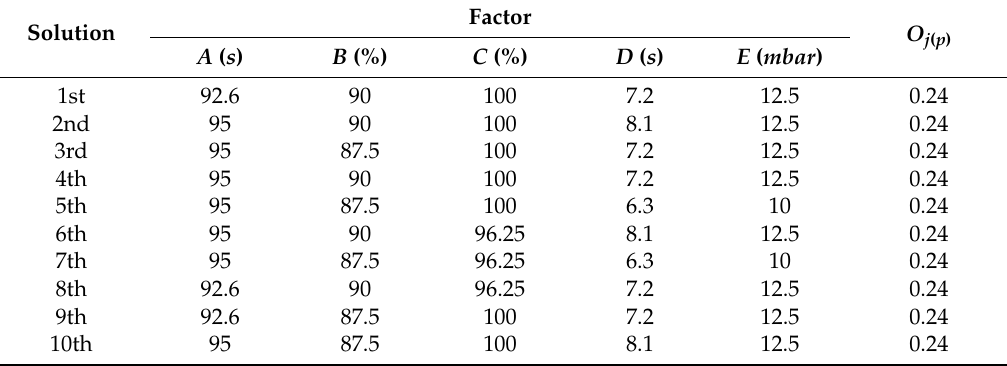
Table 7. Summary of the 10 best results of the “B” variation of the optimization algorithm. Solution